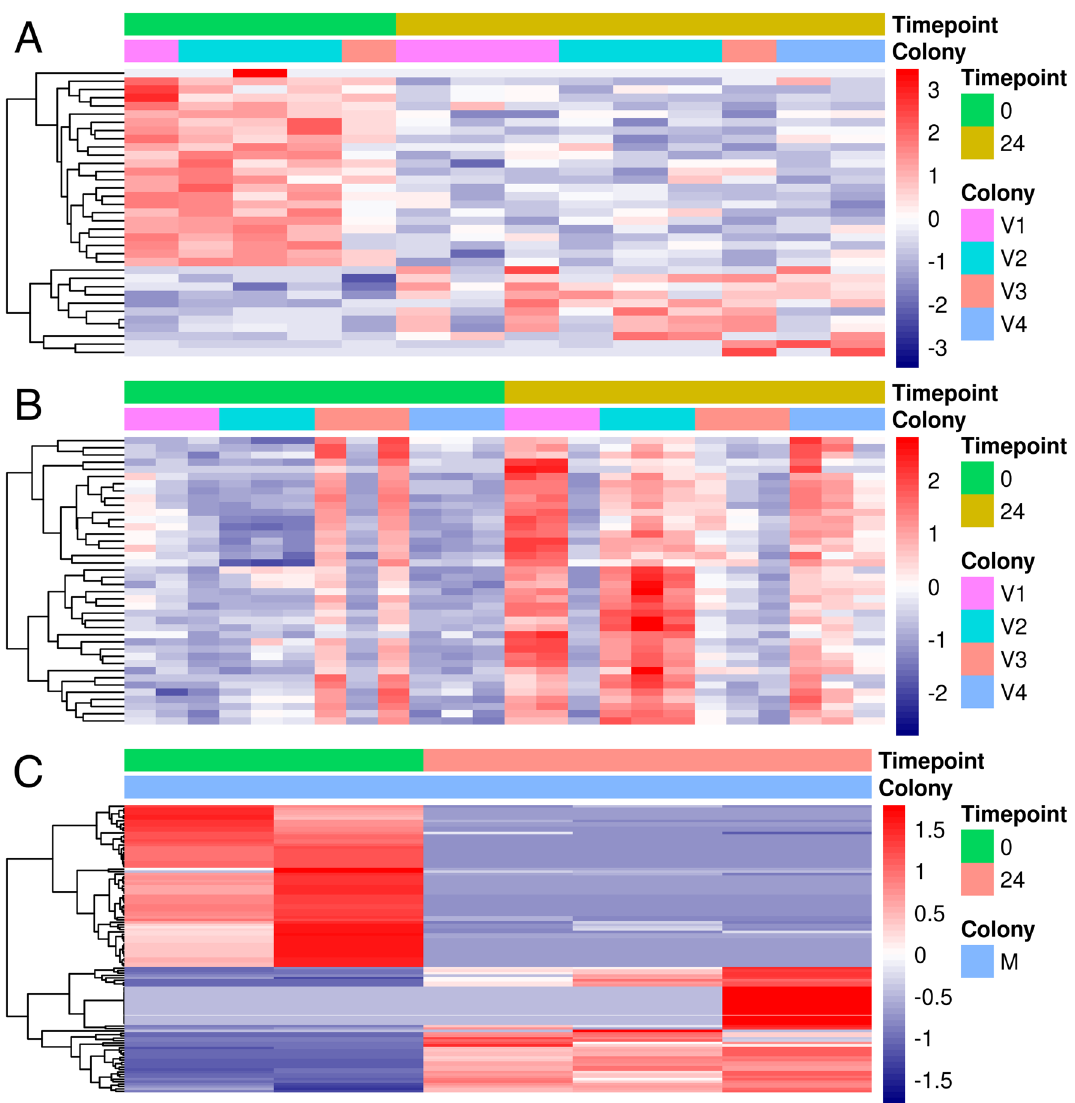
Figure 3. Heatmap summarizing the RNA-seq data of differentially expressed genes between control and treatment group (fold change > 2, p < 0.05) in ( A ) workers, ( B ) larvae and ( C ) Varroa. Red indicates up-regulation and blue indicates